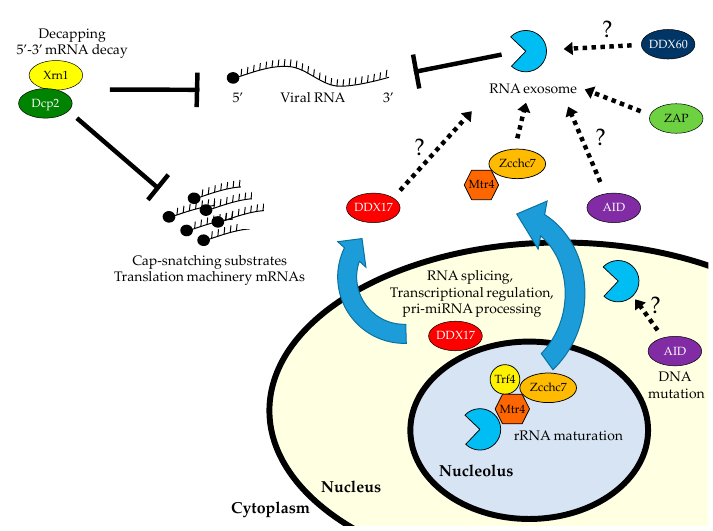
Figure 1. The 5 ′ to 3 ′ decay machinery can inhibit viral infection directly through degradation of viral RNA (vRNA; flaviviruses) or indirectly through decapping and degradation of RNAs needed for viral transcription and translation (bunyaviruses). The 3 ′ to 5 ′ decay machinery, the RNA exosome, interacts with a variety of RNA ‐ binding proteins, some of which are exported to the cytoplasm in response to viral infection. Recruitment of the exosome can result in degradation of vRNA.